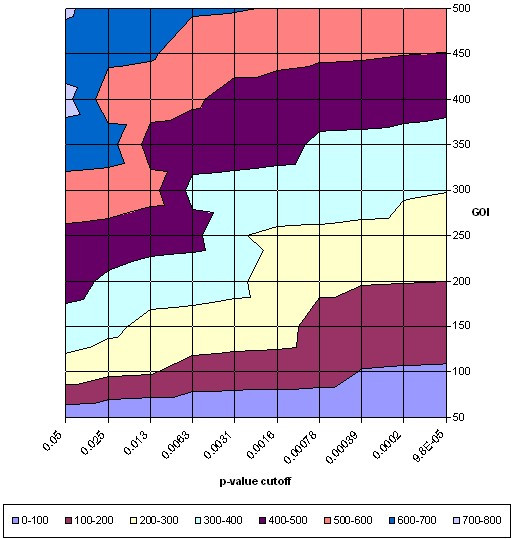
Overhead view of surface topology for the portion of the Meiklejohn data set that did not overlap the Arbeitman data set. Different shadings represent different numbers of significant terms.